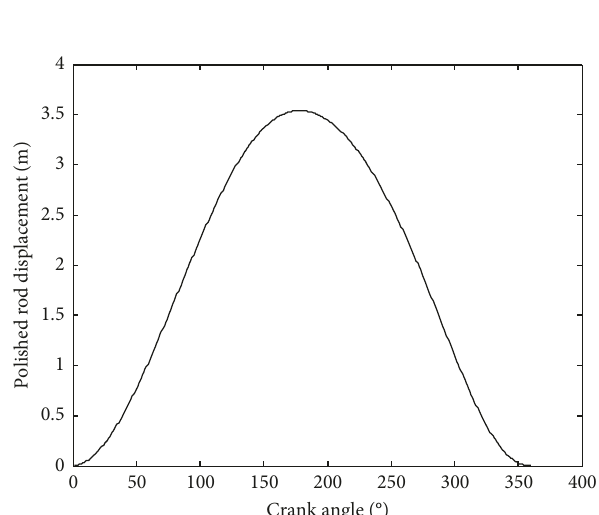
Figure 10: The displacement curve of polished rod.